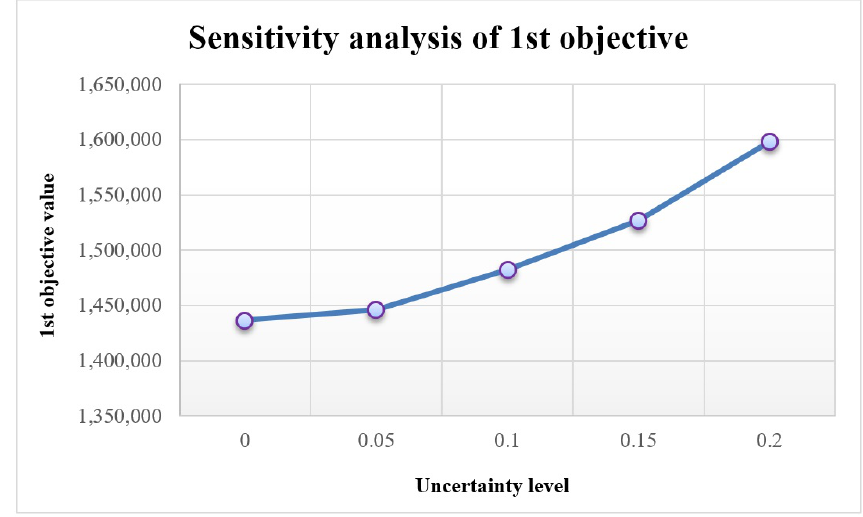
Figure 3. Sensitivity analysis of the 1st objective on different uncertainty levels.